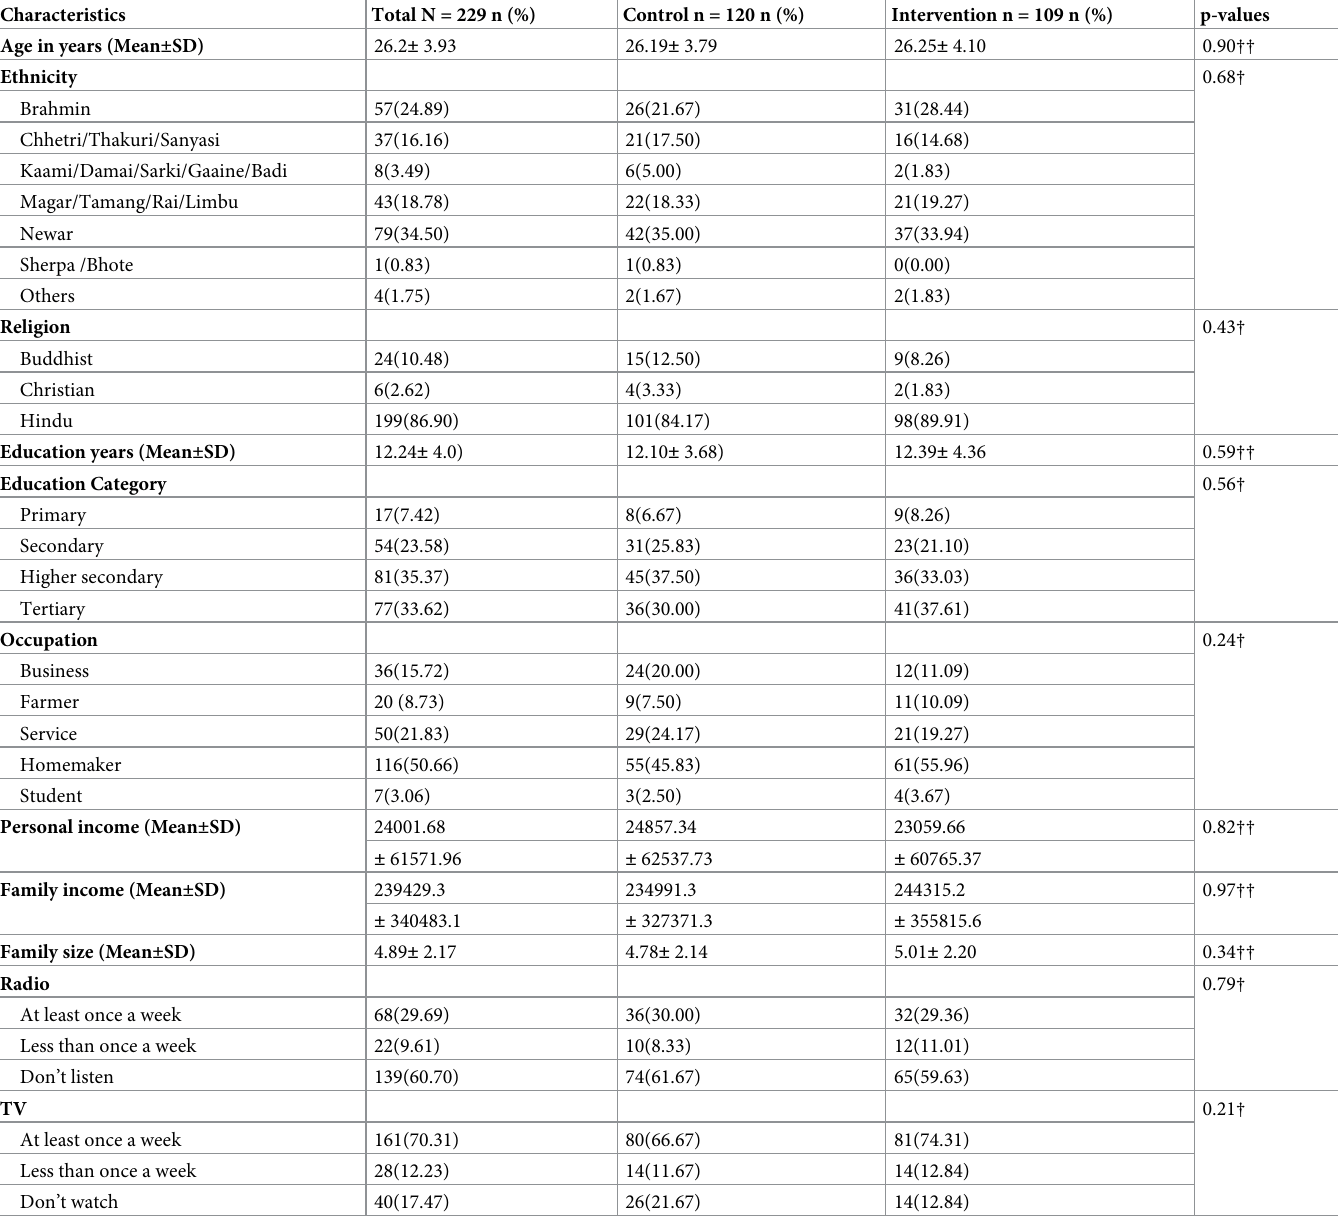
Table 3. Socio-demographic characteristics of the study participants in intervention and control group at baseline, n = 229.